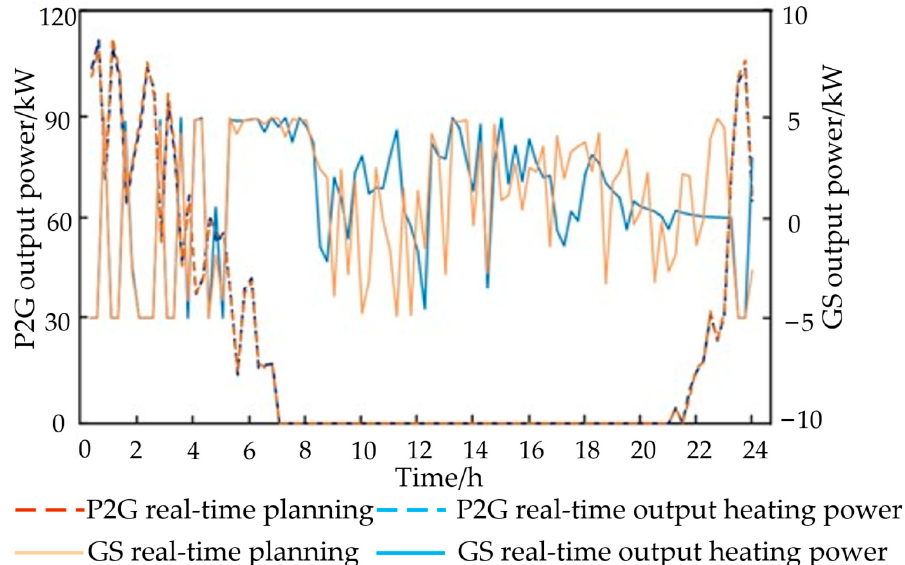
Figure 9. Comparison of real-time planning and actual output of P2G and gas storage devices.